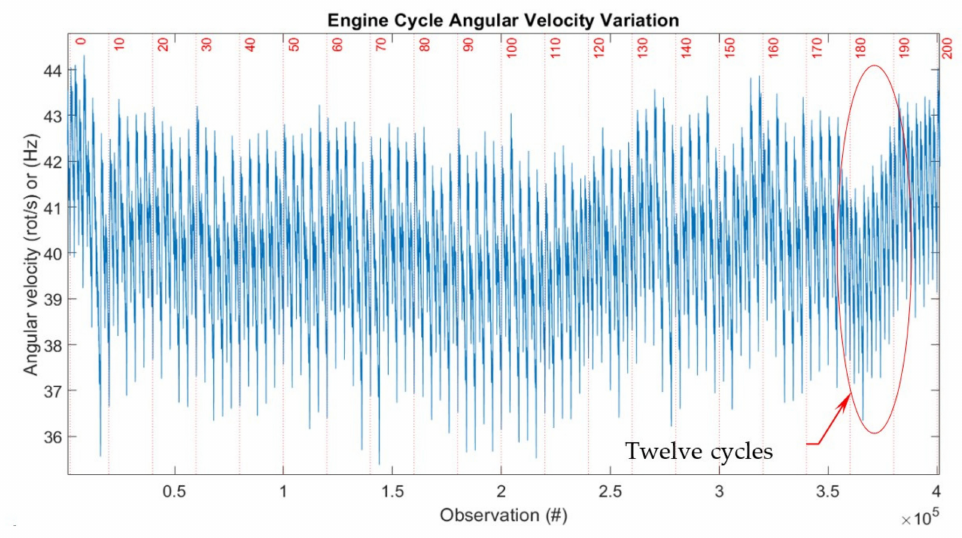
Figure 13. Representation of 199 consecutive engine cycles. # stays for the number i.e., Observa- tion